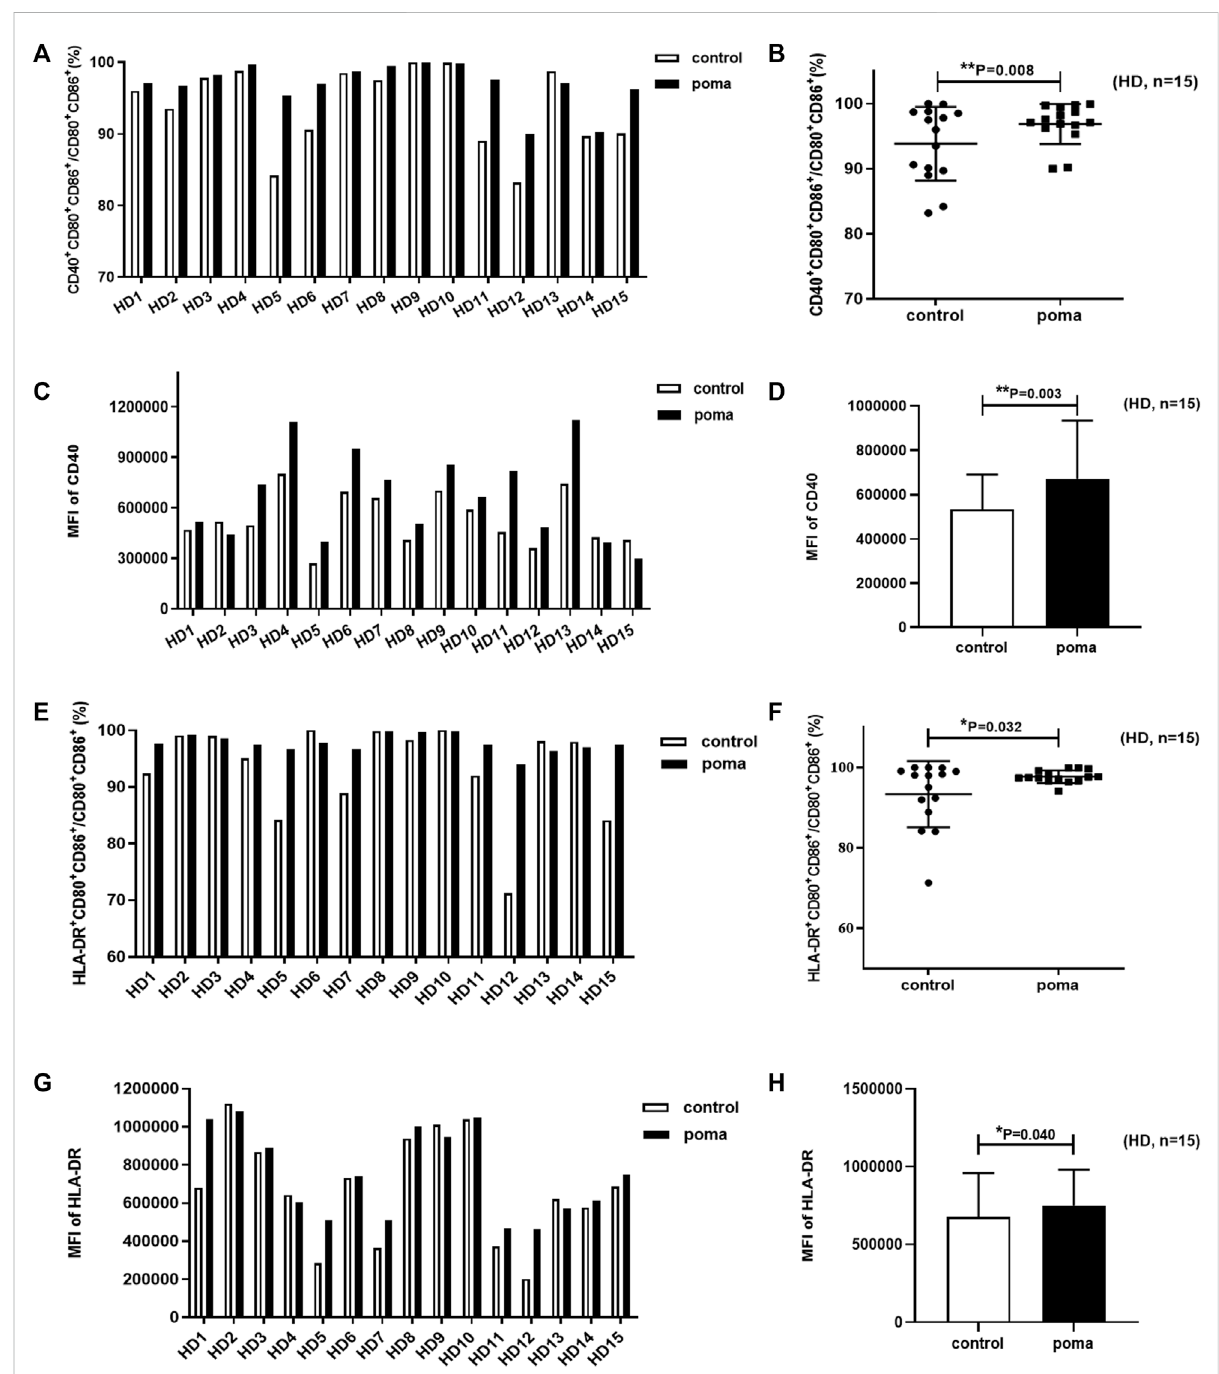
Theeffectofpomalidomide ontheexpressionofmaturation-related surfacemarkersofHD-moDCs( n =15).Theproportion ofCD40 + moDCs in total moDCs was shown in (A,B) while the MFI of CD40 expression on moDCs was shown in (C,D) . The proportion of HLA-DR + moDCs in total moDCs was shown in (E,F) while the MFI of CD40 expression on moDCs was shown in (G,H)